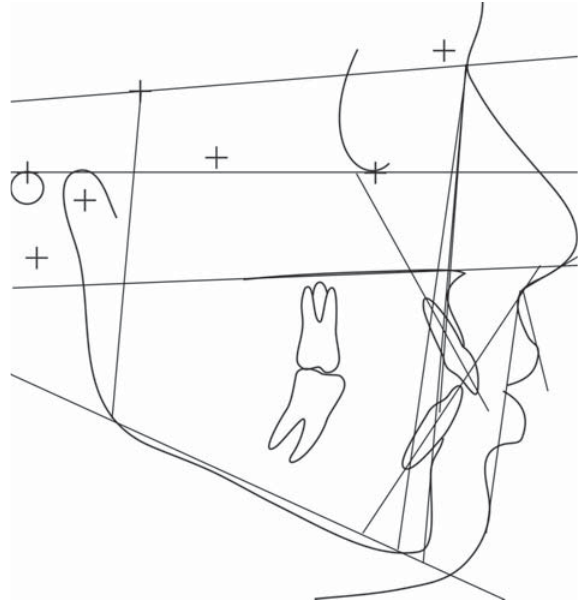
Figure 3- Cephalometric patterns of the Afro-Caucasian